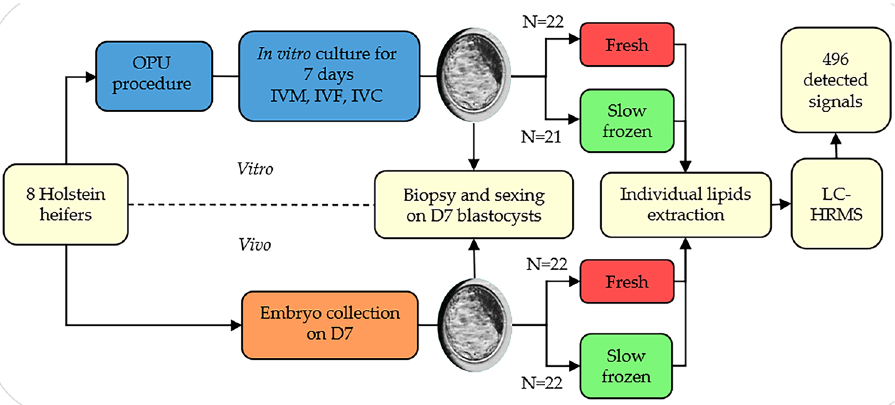
Figure 1. Experimental design. Eight Holstein heifers enabled the production of in vitro and in vivo embryos by OPU-IVF and embryo collection procedures. After seven days of development, all grade 1 expanded blastocysts were biopsied and sexed. Half of each group underwent lipid extraction in a fresh state, the other half were first frozen before undergoing lipid extraction. Lipid extracts were analysed by liquid chromatography- high resolution mass spectrometry and allowed the detection of 496